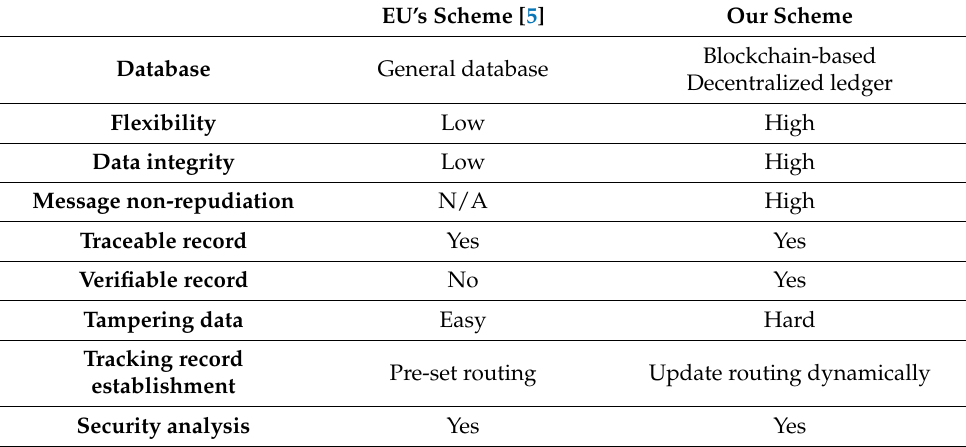
Table 6. Comparison of the tobacco products logistics